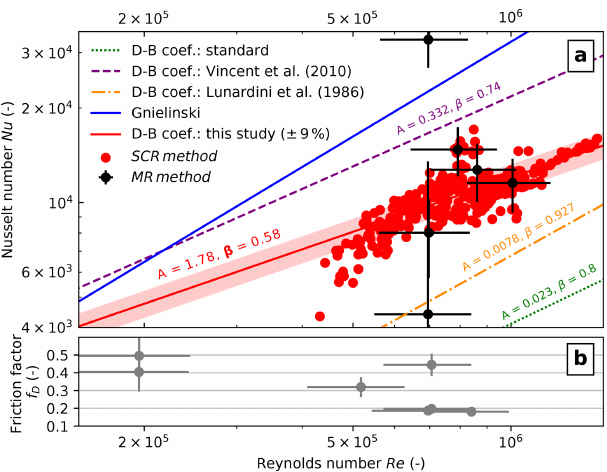
Figure 9. The Nusselt number (a) and friction factor (b) against the Reynolds number (Eq. 7). Note that all quantities are dimen- sionless. The Nusselt number from our observations is calculated using the melt-rate method at P3 (Eq. 2) and the spatial-cooling- rate method (Eq. 12). The band shows the mean relative error of 9%. The Nusselt number is also calculated from the Dittus–Boelter equation Eq. (9) using coefficients (named “D–B coef.” in the leg- end) from other studies (see Table 4) and the Gnielinski correlation (Eq.